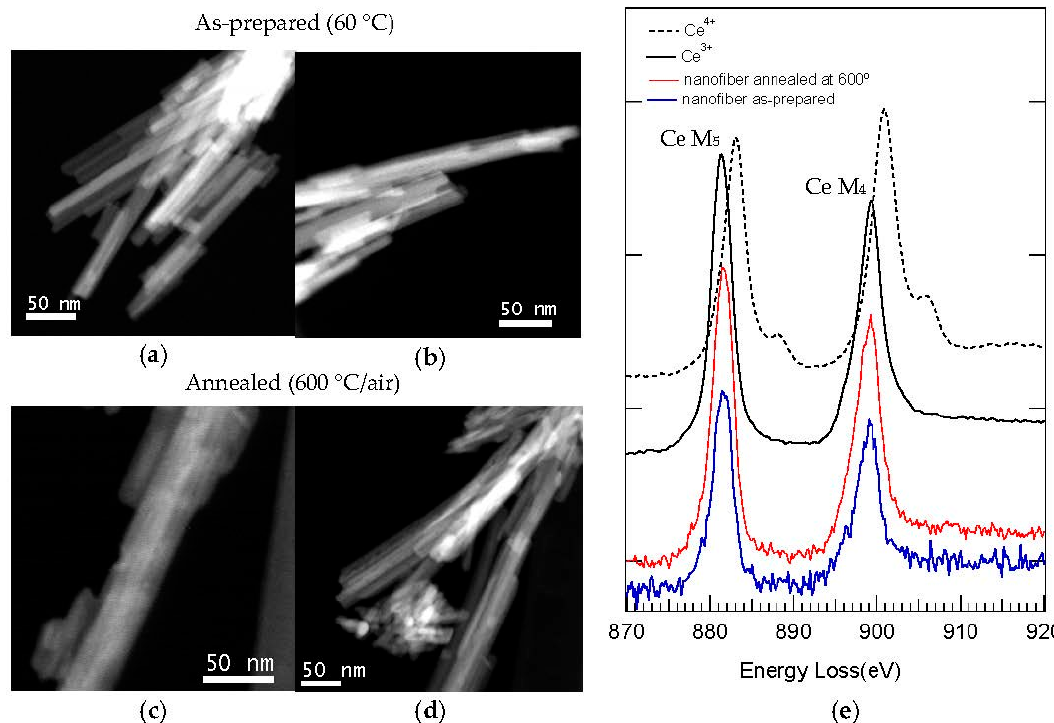
Figure 13. ( a – d ) STEM-HAADF images of C12GA-templated CePO 4 sample, as-prepared ( a and b )